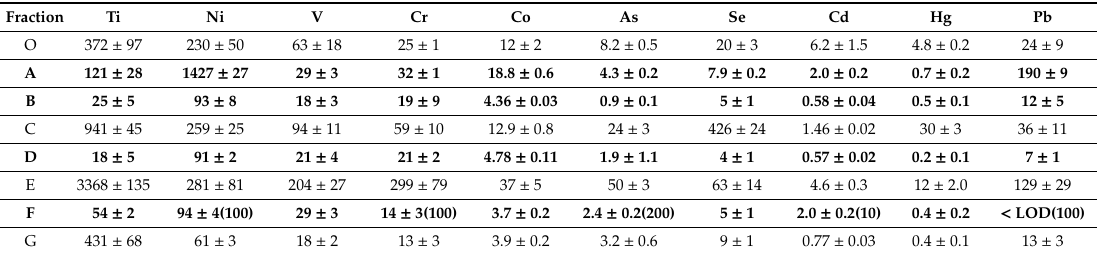
Table 2. Concentrations ( µ g kg − 1 ) found for trace elements in the di ff erent fractions of the winemaking process without added yeast